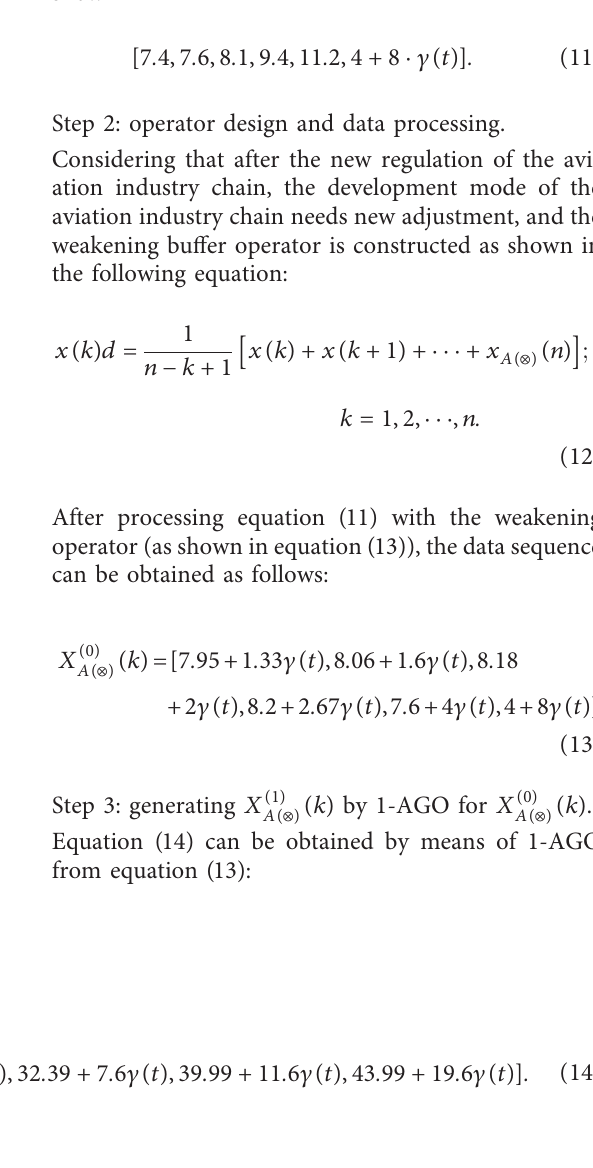
Step 1: sorting out the original initialization sequence.